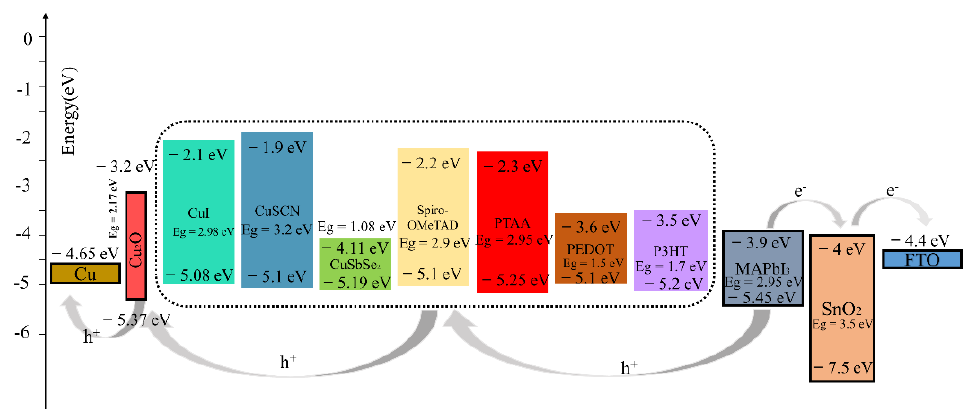
Figure 5. Energy diagram for devices with different HTLs.